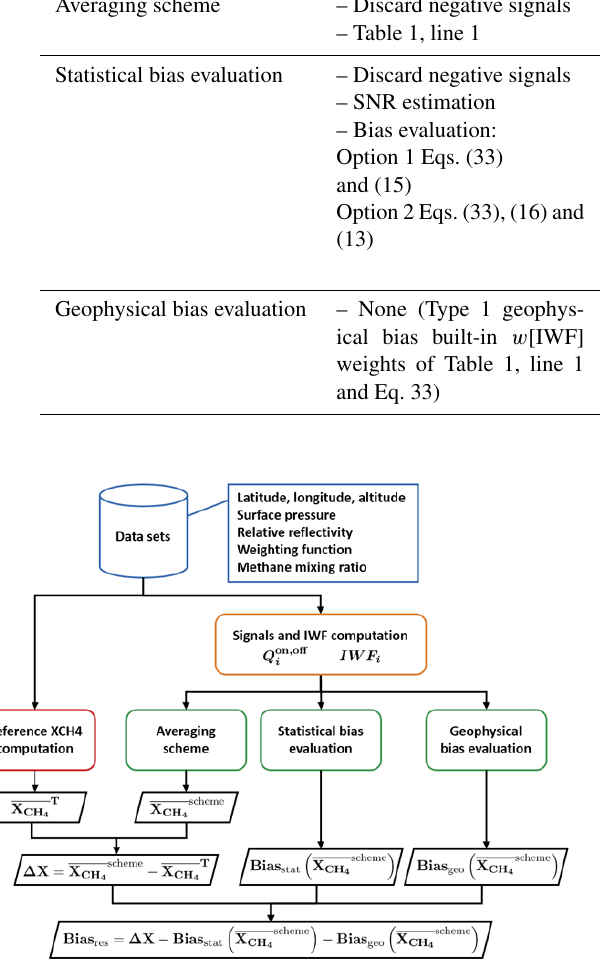
Figure 8. Global description of the simulation. Data sets (blue) are described in Sect. 4.1. Signals and the IWF computation (orange) are described in Sect. 4.3. Averaging strategies performed and their related bias corrections (green) are described in Sect. 4.4 and Ta- ble 4. Target X CH computation (red) is described in Sect. 3.1. (cid:49)X 4 is the scheme bias which is the difference between scheme and tar- get X CH , and Bias res is the residual bias when evaluated biases 4 have been subtracted from the scheme